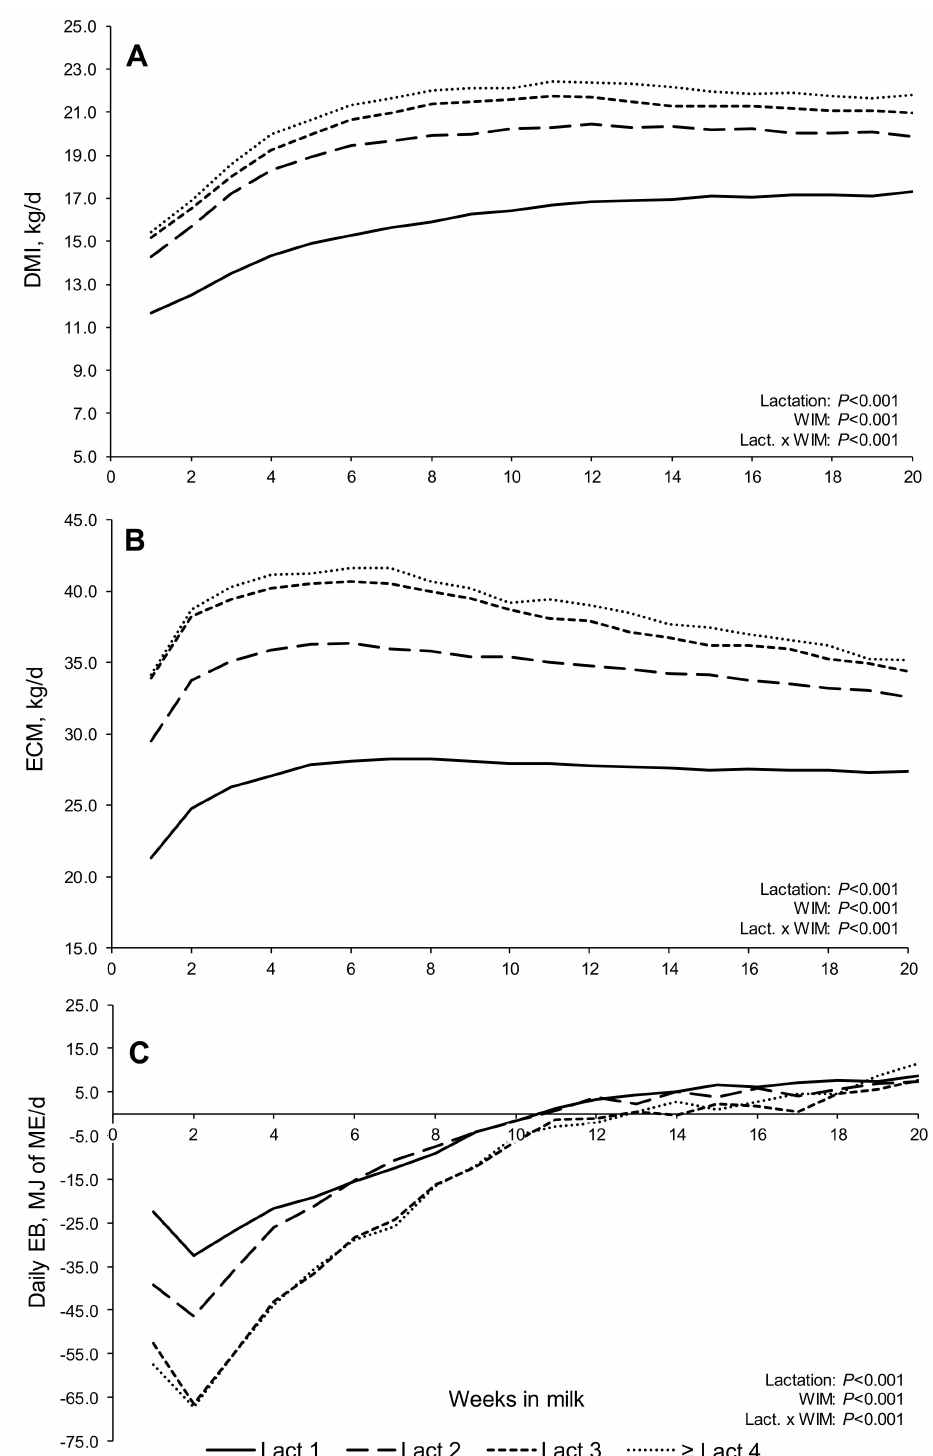
Figure 1. Least squares means, adjusted by the random crossed effects of study and cow, for dry matter intake (DMI; ( A )), energy-corrected milk (ECM; ( B )), and estimated energy balance (daily EB; ( C )) according to equations within ‘Feed into Milk’ [36], in early lactation dairy cows (1–20